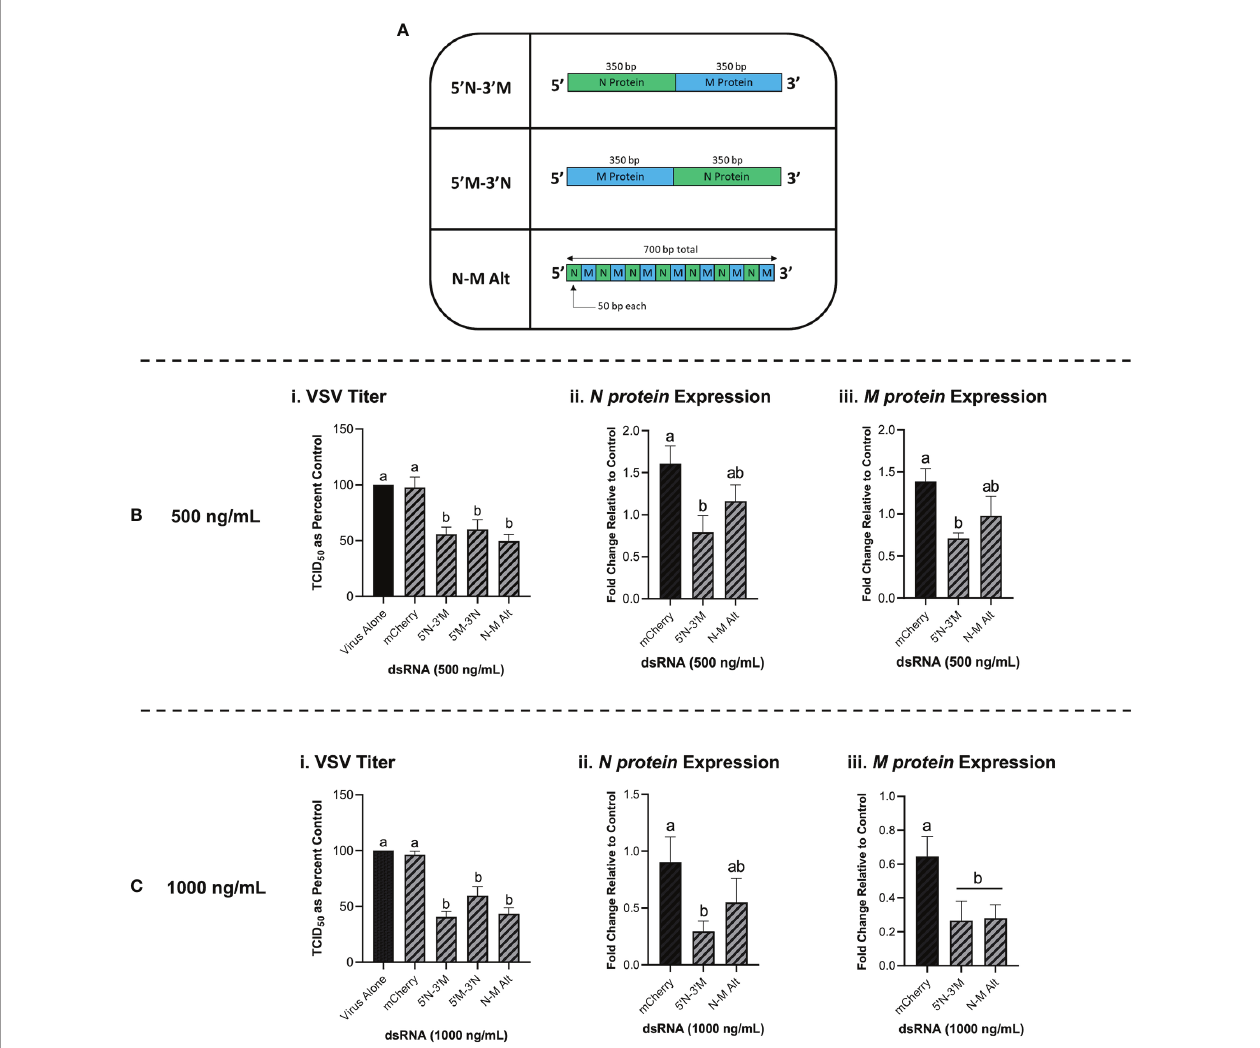
FIGURE 7 | Combination dsRNA molecules can inhibit viruses through the knockdown of multiple viral genes. Three different 700 bp combination genes were synthesized using gBlocks referred to as 5 ’ N-3 ’ M, 5 ’ M-3 ’ N and N-M Alt (A) . THF cells were pre-soaked for 2h with DPBS or 500 ng/mL of either mCherry, 5 ’ N-3 ’ M, 5 ’ M-3 ’ N or N-M Alt before being exposed to VSV-GFP (MOI = 0.1) for 24h (Bi) . Following this treatment, cells were collected and RNA extracted so that gene expression of the VSV N protein gene (Bii) and M protein gene (Biii) could be measured by qRT-PCR. THF cells were also pre-soaked for 2h with DPBS or 1000 ng/mL of either mCherry, 5 ’ N-3 ’ M, 5 ’ M-3 ’ N or N-M Alt before being exposed to VSV-GFP (MOI = 0.1) for 24h (Ci) . Following this treatment, cells were collected and RNA extracted so that gene expression of the VSV N protein gene (Cii) and M protein gene (Ciii) could be measured by qRT-PCR. Error bars represent +SEM. Each data point for the titer data represents the average of 6 independent replicates while the qRT-PCR data represents the average of 5 independent replicates. A p-value of less than 0.05 was considered to be statistically signi fi cant. Error bars with different letters represent signi fi cantly different